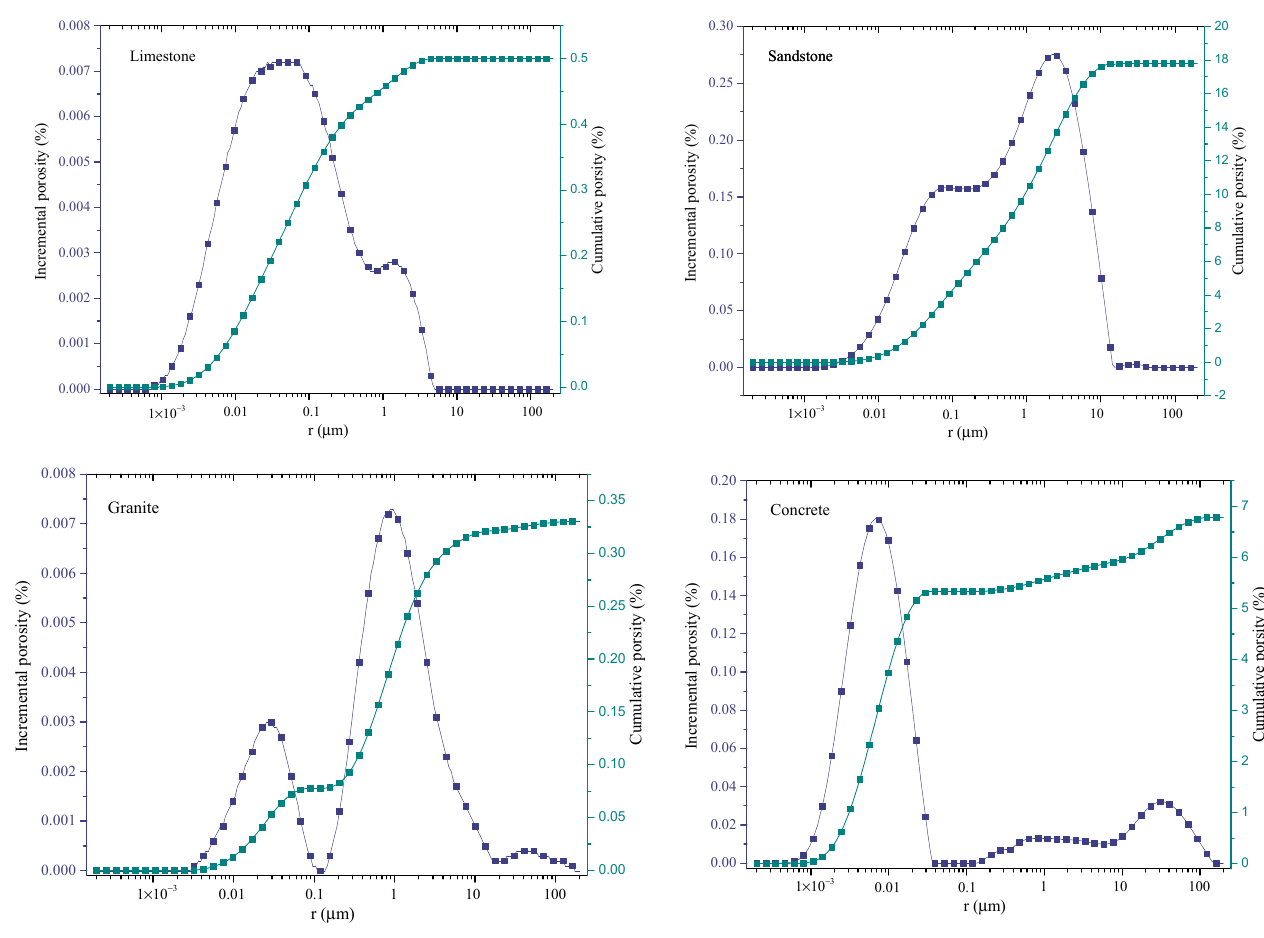
Figure 3. Comparison of pore size distribution of rock.